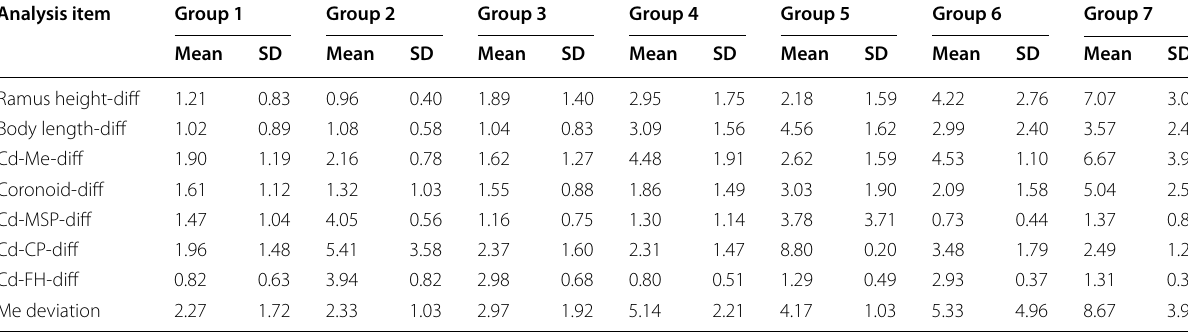
Table 4 Mean values and standard deviation of analysis items in each group Analysis item